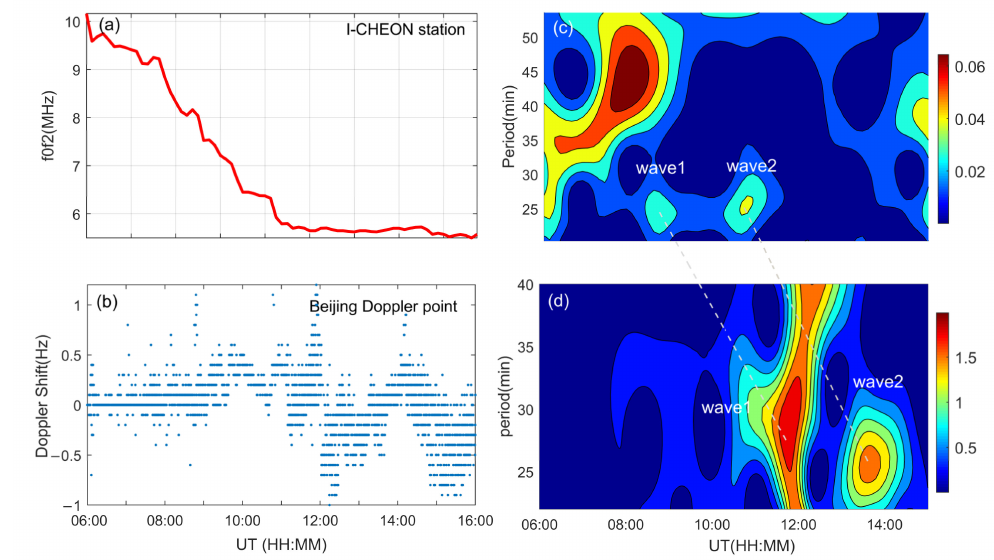
Figure 6. Variations of the f o F2 and Doppler shift and their spectrum analysis on 11 March 2011. ( a ) Ionospheric f o F2 variations recorded by the I-CHEON Digisonde and ( c ) its time-period spectrum. ( b ) Variations of the Doppler shift recorded by the Beijing Doppler receiver and ( d ) its temporal